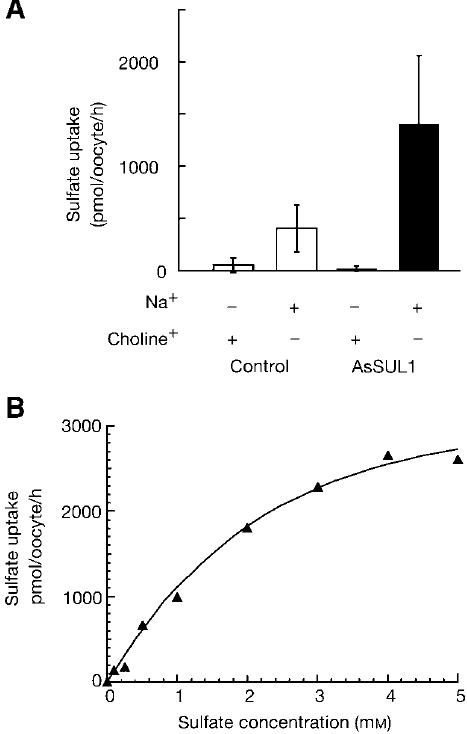
Figure 4 As SUL1 expression in Xenopus oocytes. (A) Na q dependency of sulfate uptake by AsSUL1. The initial sul- fate concentration was 1 m M . (B) Kinetic properties of AsSUL1. Sulfate uptake was measured with increasing concentrations of sul- fate in the presence of (35S) sulfate in uptake buffer containing and V values of AsSUL1 were 1.75 m M 100 m M NaCl. The K m max and 2500 pmol/oocyte/h, respectively. Reproduced from Ref. (97).